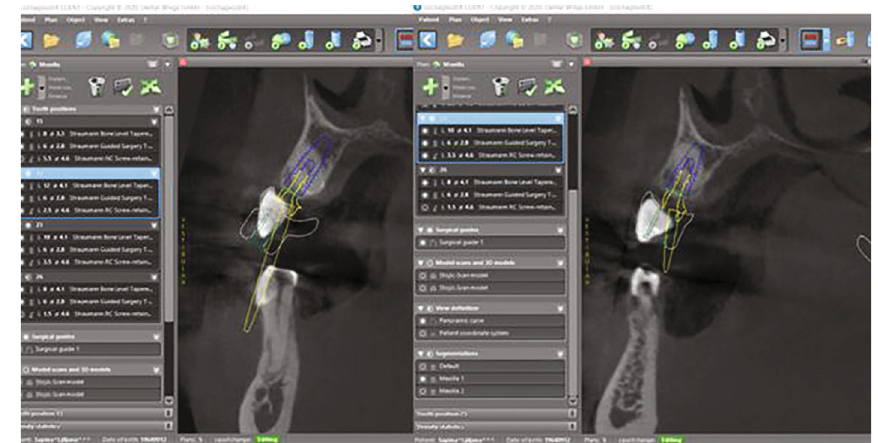
Figure 3: 3D planning — transcanine approach in regions 13 and 23.